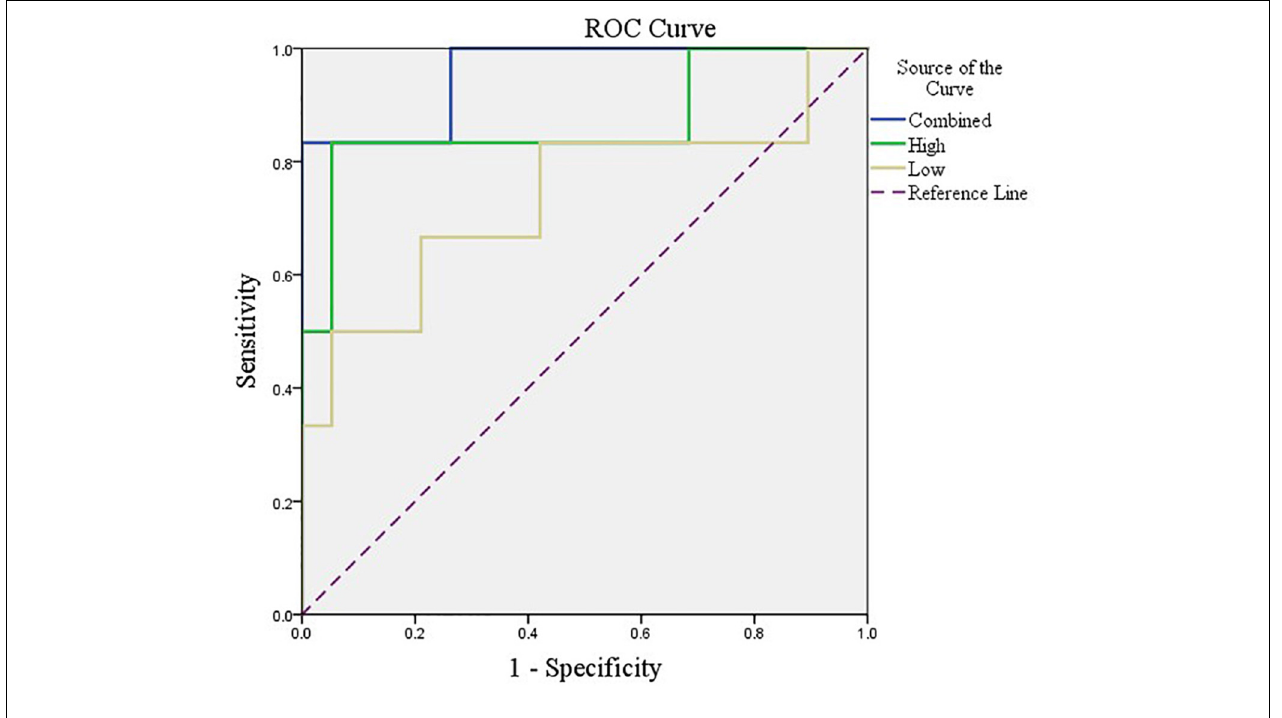
FIGURE 8 | ROC curves corresponding to the three methods.